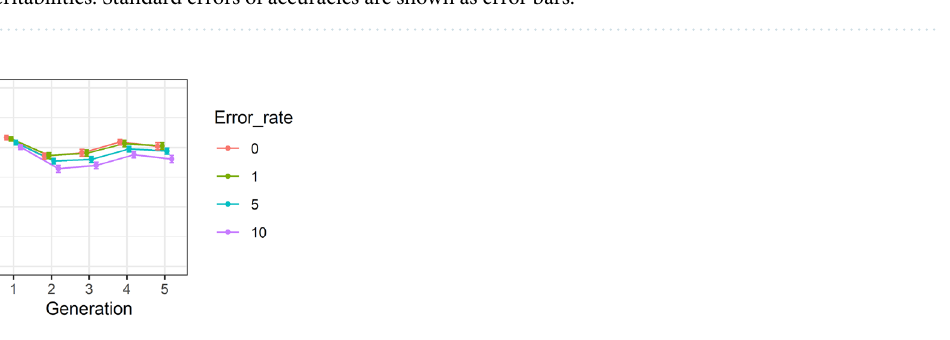
Figure 9. Accuracy of genomic estimated breeding values for 0.5, 3, 10 and 20 K SNP densities over genotypic error rates of 0, 1, 5 and 10%. Correlations are averaged over different generations, replicates, family types and trait heritabilities. Standard errors of accuracies are shown as error bars.